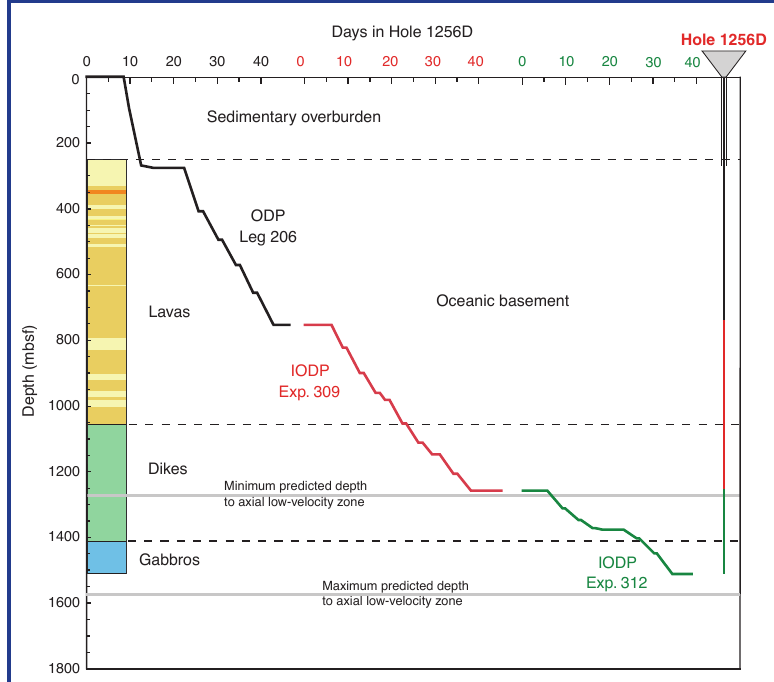
Figure 6. Drilling progress versus time in Hole